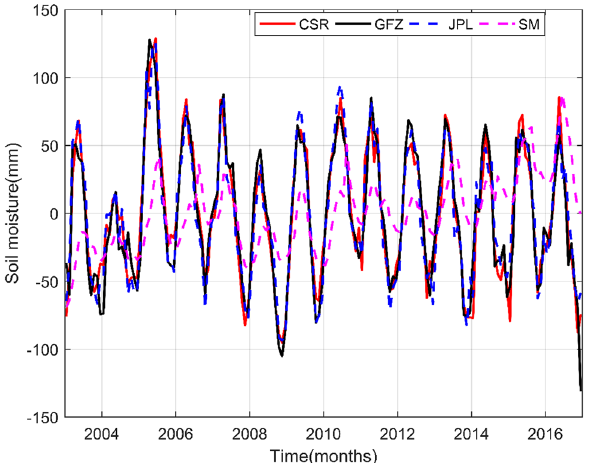
Fig. 8 Residual mean monthly snow water equivalent variation (mm) of GB from GLDAS-Noah model and residual mean monthly TWS change from GRACE (CSR, GFZ, JPL)